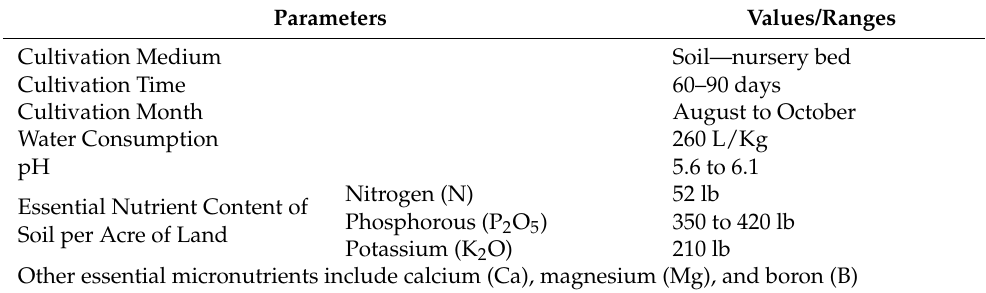
Table 2. Parameters and their corresponding values in the substrate cultivation method.